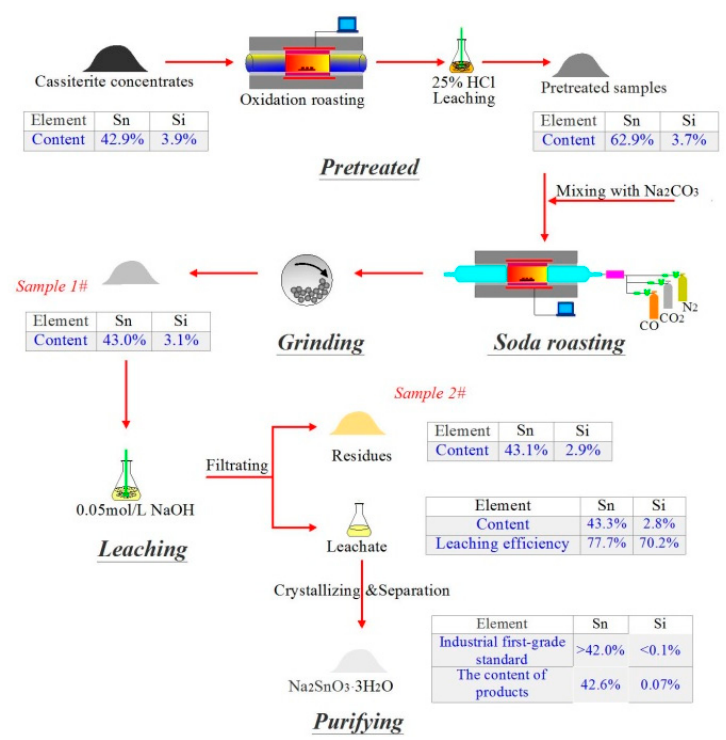
Figure 3. Distribution of Sn and Si elements in the whole experimental flowsheet (under the most suitable conditions).